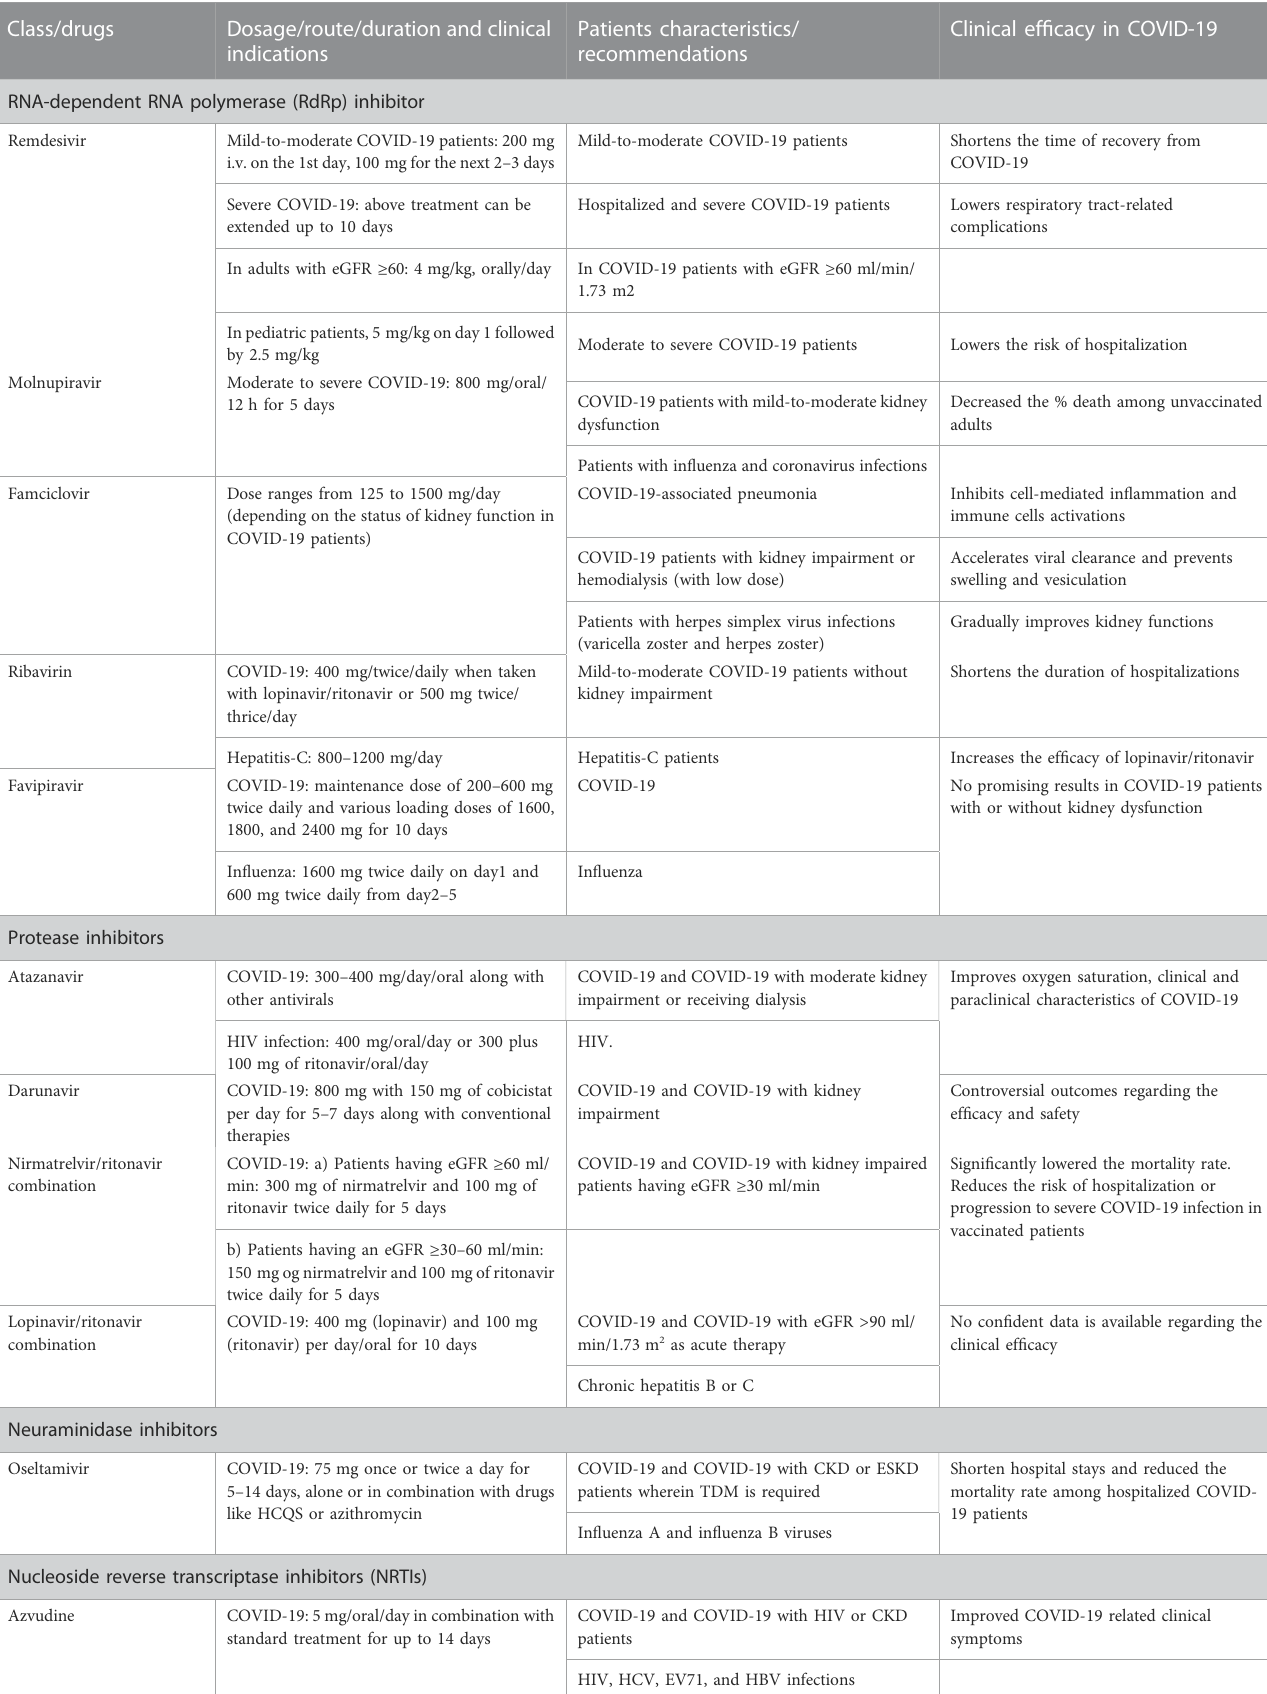
TABLE 2 Dosage, clinical indications and ef fi cacy of antivirals and monoclonal antibodies in COVID-19 patients.